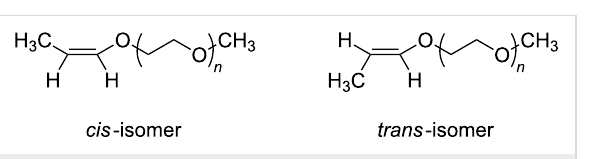
Figure 3: Investigation of grafting allyl-PEO350 onto the PSZ chain by 1 H NMR (SiH/allyl = 10).